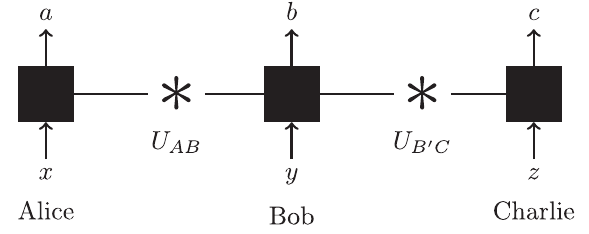
FIG. 2. The quantum tripartite line in the device-independent